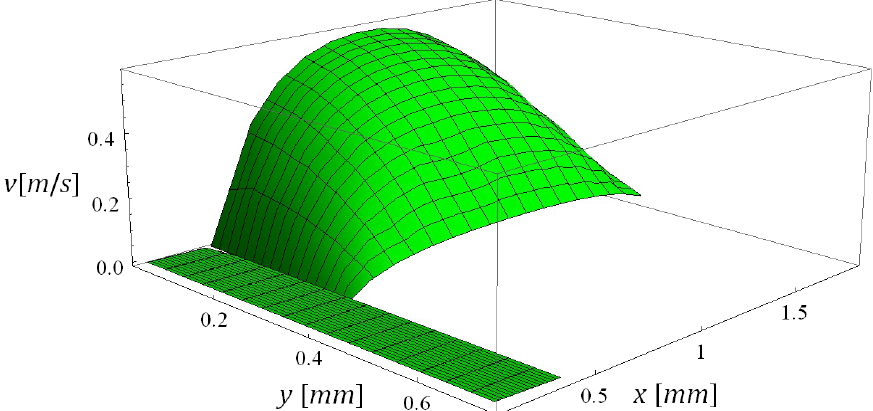
Figure 16. Cross-sectional profile of absolute velocity of cathode gas at cross-section midway between inlet and outlet as obtained by CFD simulation.